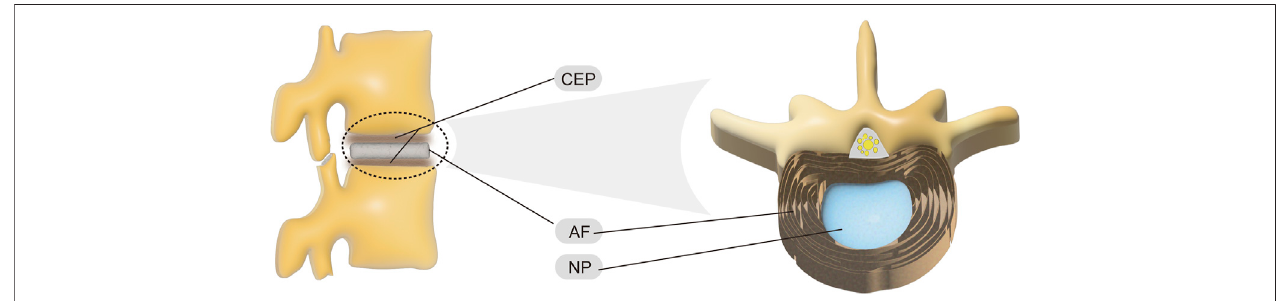
FIGURE 1 | Structure of normal